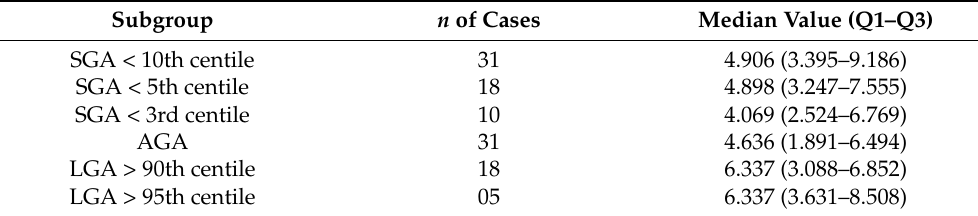
Table 2. FGF21 median values (pg/mL) and Q1–Q3 ranges by fetal size subgroups, including ex- tremes of distribution.